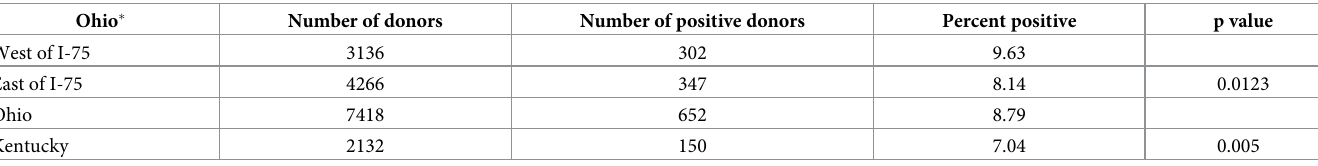
Table 6. Rate of S protein ELISA positivity clustered by regions within the